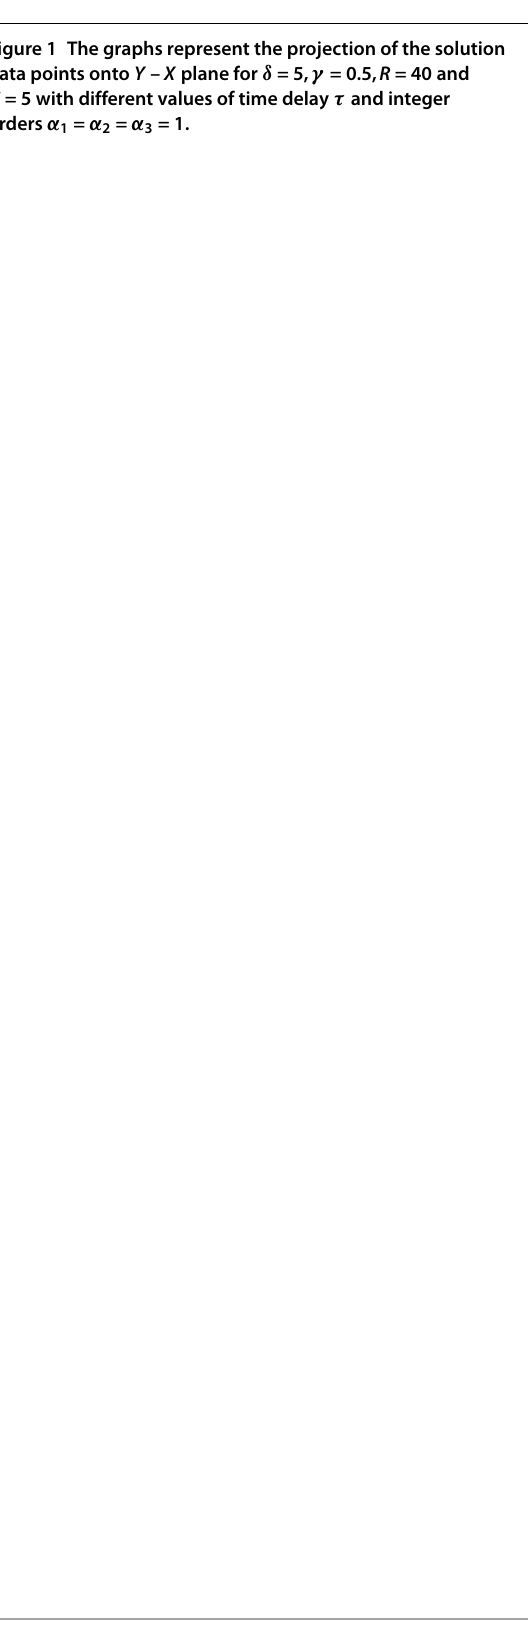
Figure 1 The graphs represent the projection of the solution data points onto Y – X plane for δ = 5, γ = 0.5, R = 40 and G = 5 with different values of time delay τ and integer orders α 1 = α 2 = α 3 =